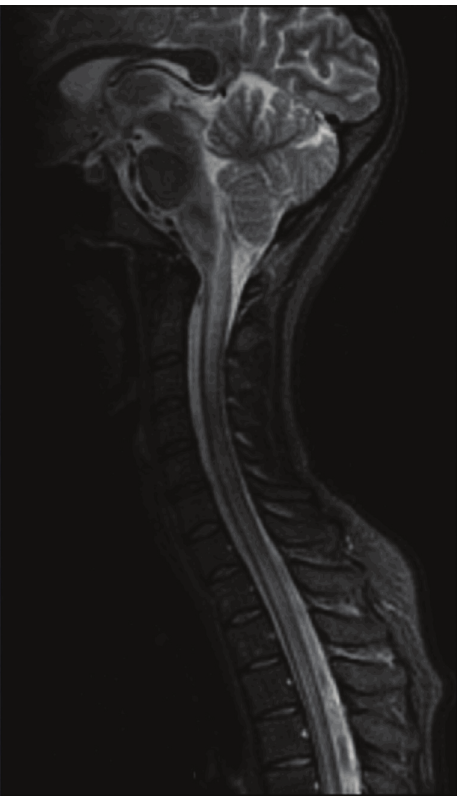
Figure 2. Sagittal T2-weighted image shows an extensive hyperintensity involving the medulla oblongata and the cervico- toracic cord, compatible with a myelitis pattern. Figure origin: Department of Radiology, Hospital Clinic Barcelona.